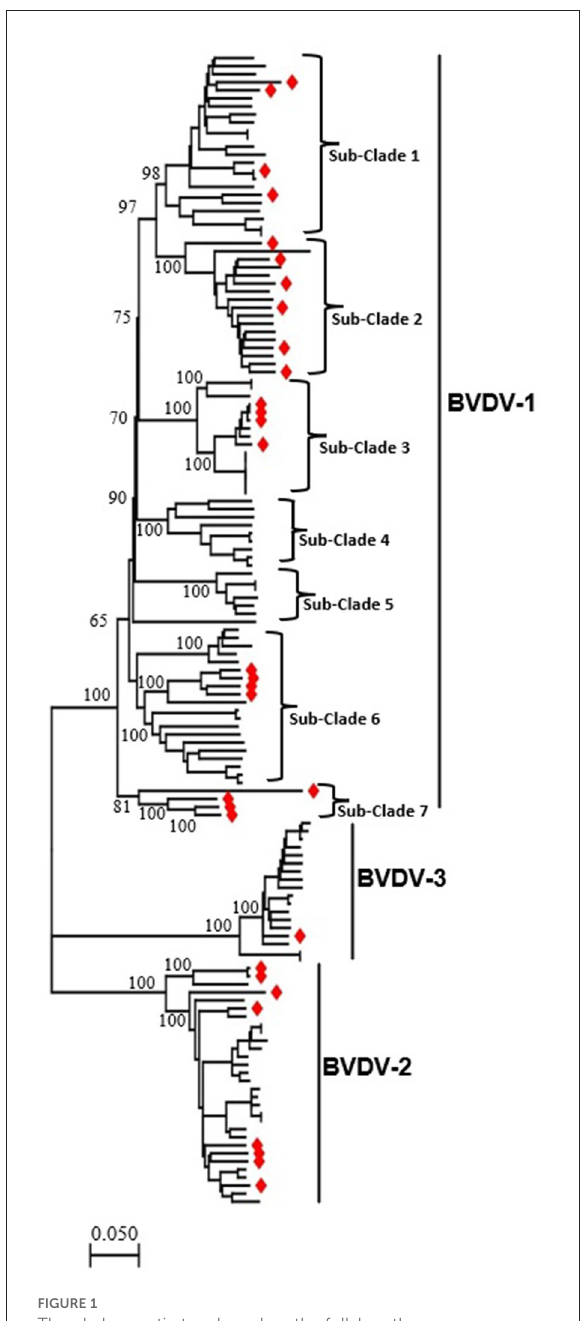
FIGURE1 The phylogenetic tree based on the full-length genome sequences of BVDV strains reported around the world, including China. An ML phylogenetic tree of 143 full-length BVDVs genome classifying all the strains into three major clades (BVDV-1, BVDV-2, and BVDV-3). The major clades and sub-clades of the BVDV are indicated. The percentage of replicate trees in which the associated taxa clustered together in the bootstrap test (1,000 replicates) are indicated at each node. The evolutionary distances were computed using the best fit substitution model (GTR + F + R4). Viruses isolated in China are labeled with red diamonds at the tips of the tree. The detailed information of BVDVs in the ML phylogenetic tree is shown in the Supplementary Figures S1,